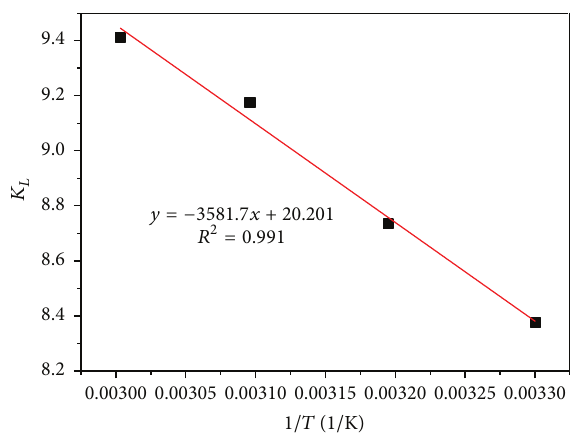
Figure 5: Van’t Hoff’s plot for AB adsorption onto diatomite: experimental variables: mass of adsorbent = 50, 100, 150, 200, 250, and 300 mg, initial concentration = 300 mgL −1 , adsorption temperature = 303, 313, 323, 333, and 343 K, volume of solution = 100mL, equilibrium time = 200 min, and pH of dyes solution = 7.